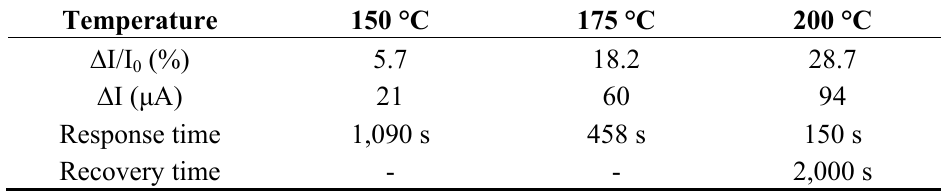
Table 3. Current variation ( ∆ I ), current variation ratio ( ∆ I/I for a Pt-InN acetone sensor under exposure to 10 ppm acetone/air at various